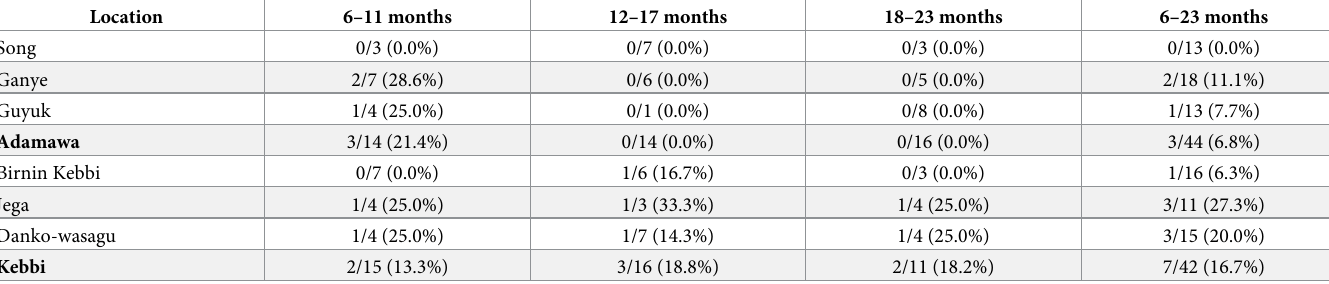
Table 2. Strict MNP users ( ± 0) according to spot check data by age group and location. Location